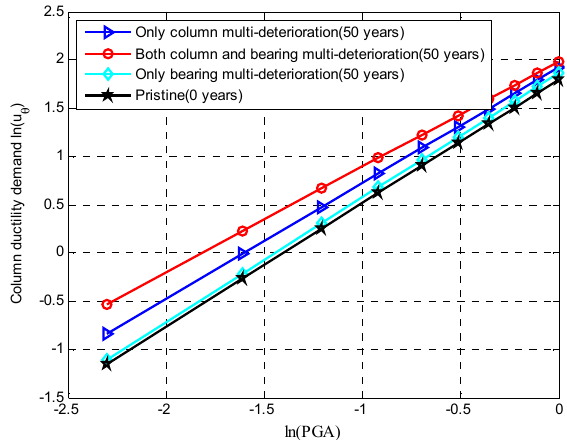
Figure 12. Mean value of the demand placed on an RC column through PSDM.